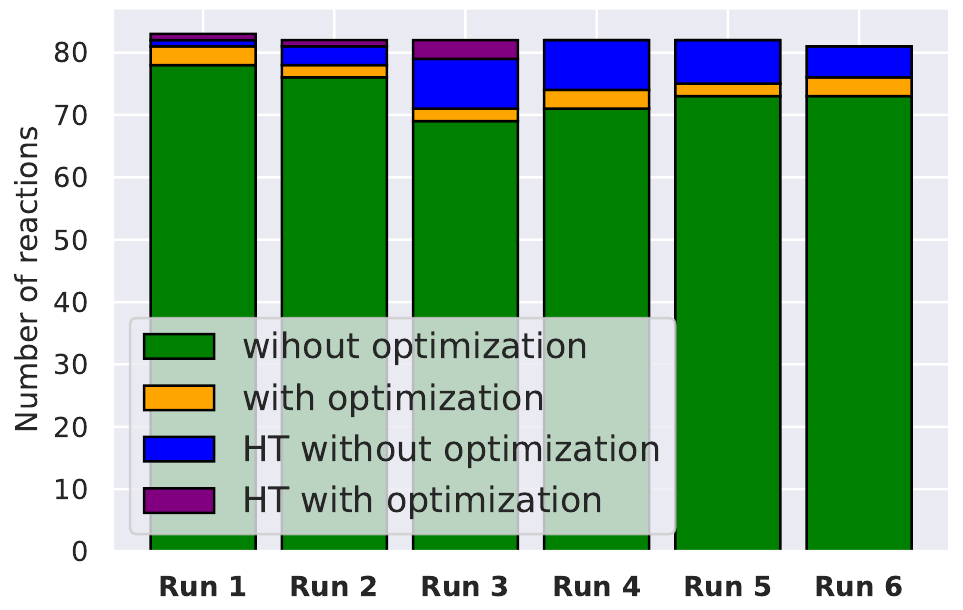
Figure 2 Distribution of the successful TSs localized for each of the 6 runs. The GFN2-xTB TS guess structure is first used directly (without optimization) in a UB3LYP/6-31G** TS optimization. If that fails to find the TS, a constraint optimization is done and the TS optimization tried again. Finally, for the failed searches, the entire procedure is run at a higher electronic temperature (HT) of 6,000 K. Run 1–3 is done with parameter set 1 and Run 4–6 done with parameter set 2